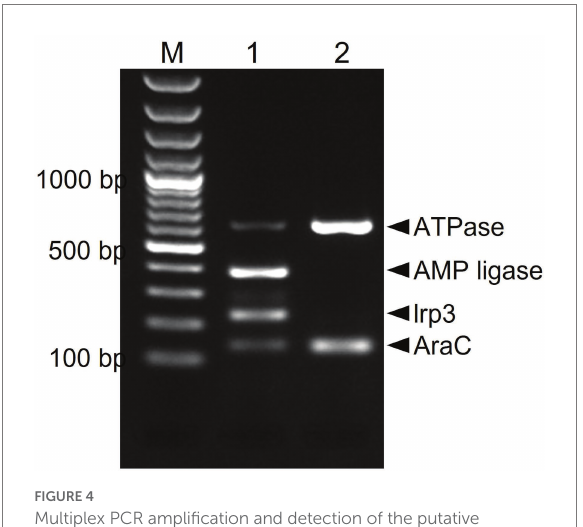
FIGURE 4 Multiplex PCR amplification and detection of the putative yersiniabactin operon genes in S. aureus. Primers targeting the AraC [139 bp], Lrp3 [228 bp], AMP ligase [390 bp], and ATPase [638 bp] genes were used. PCR amplicons were separated and visualized using agarose gel electrophoresis. M-100 bp DNA ladder, 1-ILS03 (positive control), and 2-ILS 09 (negative